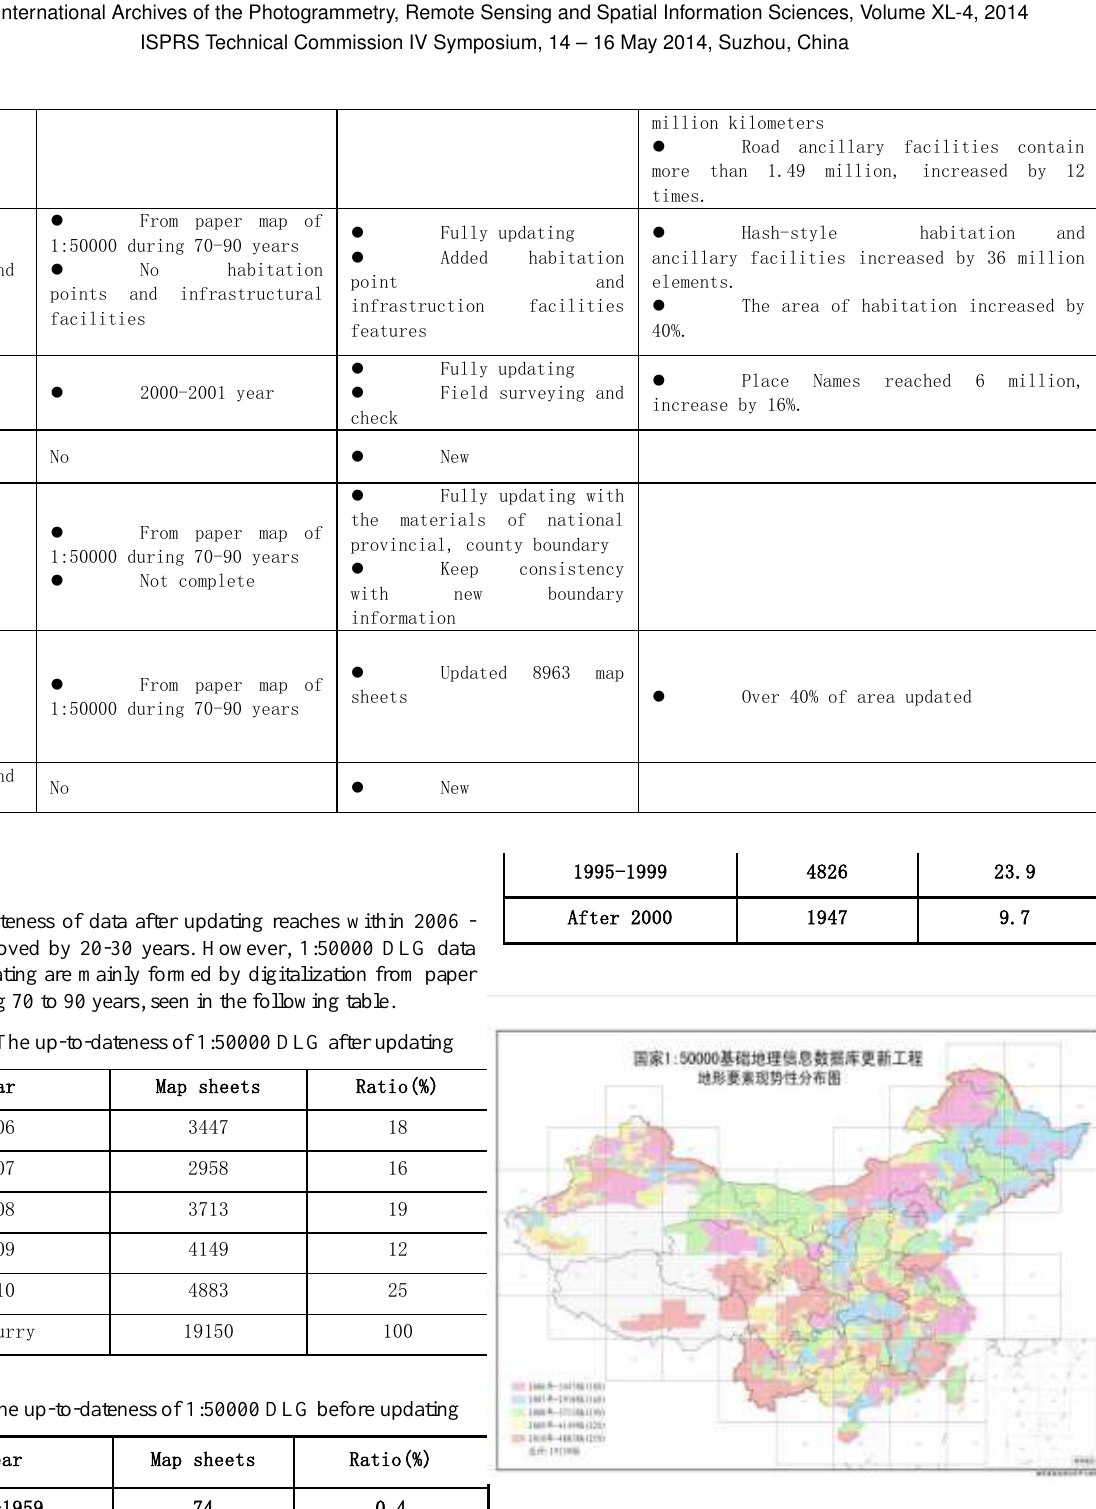
Figure 9 The up-to-dateness (year) distribution of 1:50000 DLG after